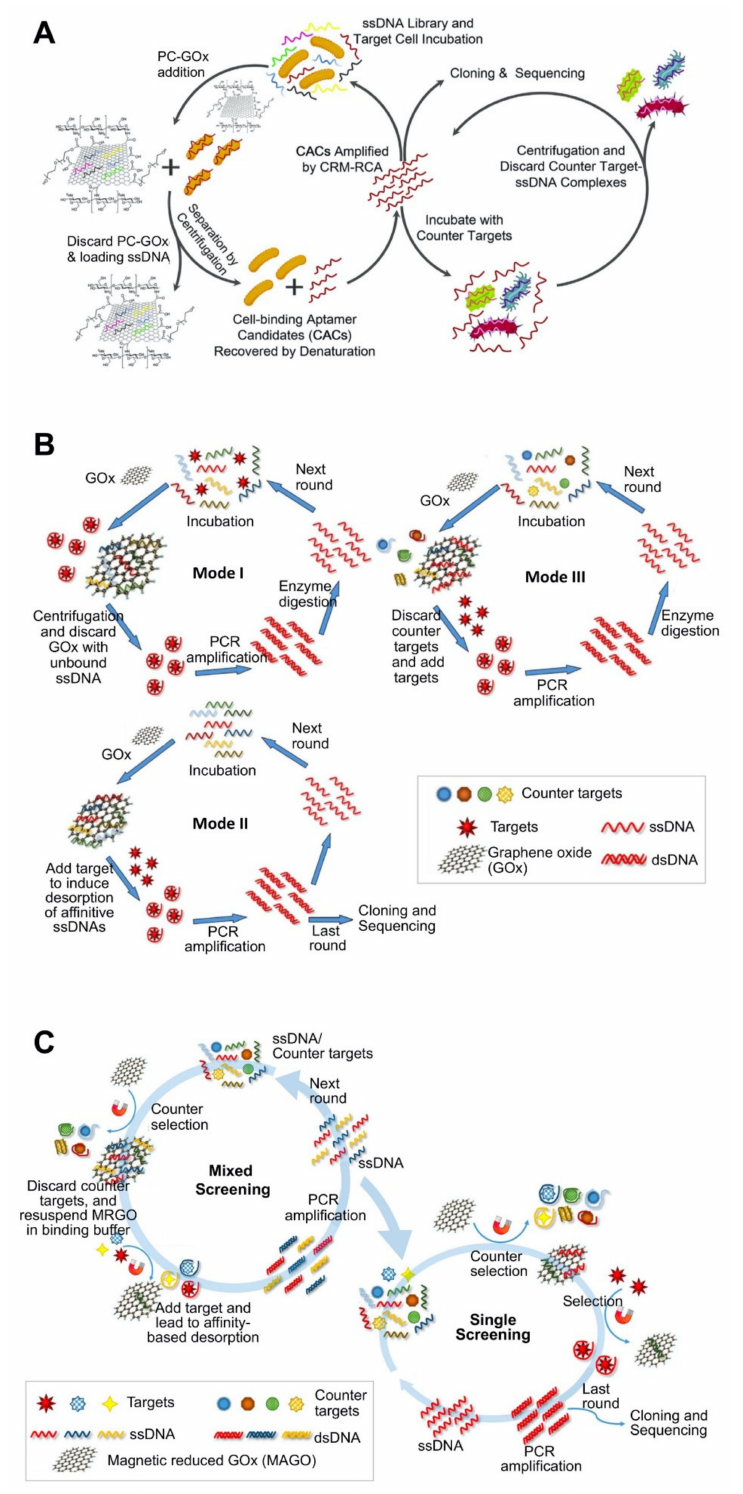
Figure 2. Aptamer discovery strategy using carbon nanomaterial-based platforms: ( A ) Vibrio para- haemolyticus -specific aptamer selection using a polyethyleneglycol and chitosan (PC)-functionalized graphene oxide (GOx) platform. Reproduced with permission from [71]; ( B ) Okdaic acid-specific aptamer selection using a GOx platform. Reproduced with permission from [72]; ( C ) Saxitoxin, domoic Acid, and tetrodotoxin-specific aptamers selection using a magnetic reduced GOx (MAGO) platform. Reproduced with permission from